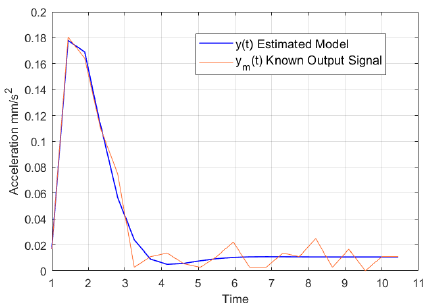
Figure 7. Graphic comparison of the reference model ˆ y and estimated model ˆ θ .